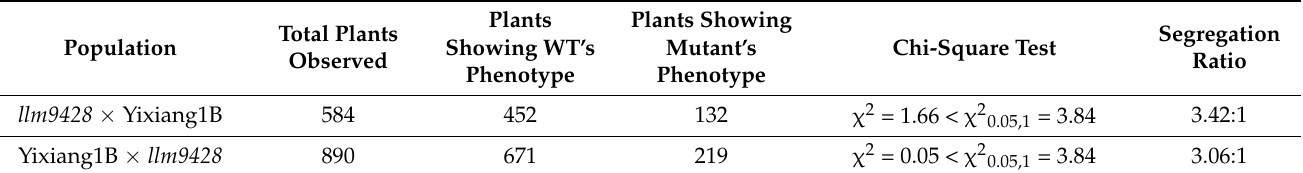
Figure 5. Comparison of total starch contents and relative expressions of its related genes in WT and llm9428 . ( A ) Comparison of starch contents in the second leaves between WT and llm9428 mutant at tillering stage (ED: end of day, EN: end of night). ( B ) Comparison of starch contents in mature grains between WT and llm9428 . ( C ) Relative expression levels of starch metabolism-related genes in leaves of WT and llm9428 at heading stage. Statistical analysis was performed using Student’s t -test, *, ** and *** indicate p < 0.05, p < 0.01 and p < 0.001, respectively. Mean and SD were obtained from three individual measurements. Table 1. Segregation ratios of F 2 plants with and without LMM